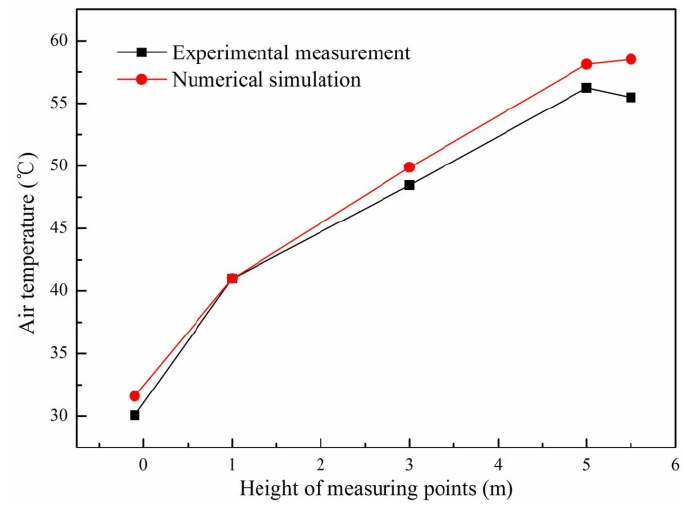
Figure 4. Comparison between the numerical simulation and experimental measurement.